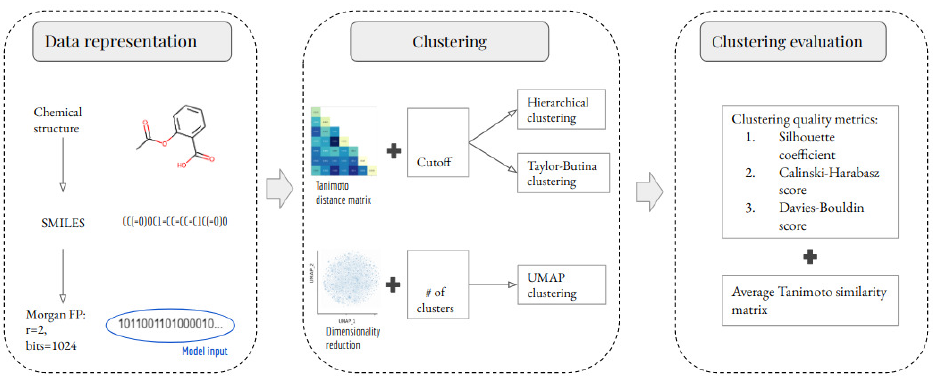
Figure 1. Schematic representation of the development of ML-based models for clustering small molecules. Chemical structures and their SMILES were retrieved from the NCI-60 dataset. SMILES were subsequently preprocessed and used to calculate the MFPs (radius 2 and 1024 bits). The MFPs were used to build and evaluate three clustering methods. Three clustering quality metrics were used to evaluate the clustering performance of each developed